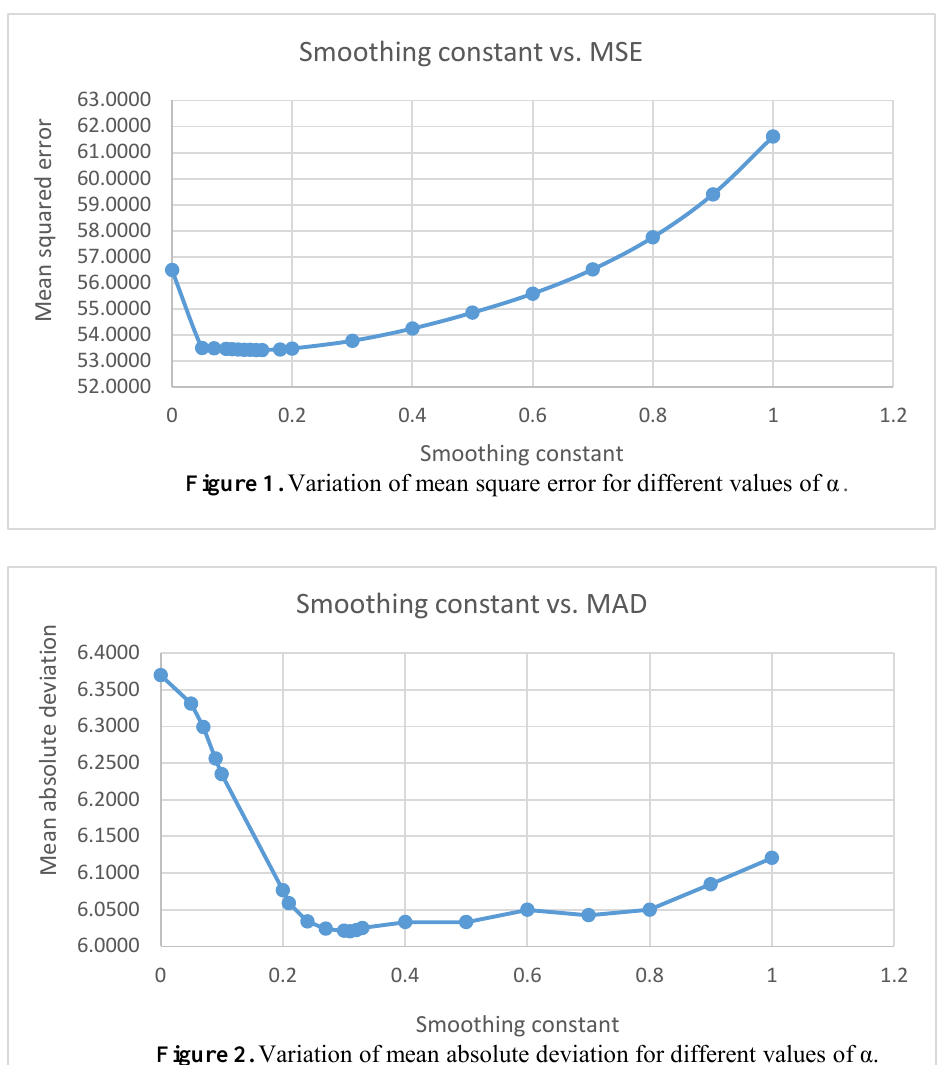
Figure 2. Variation of mean absolute deviation for different values of α.